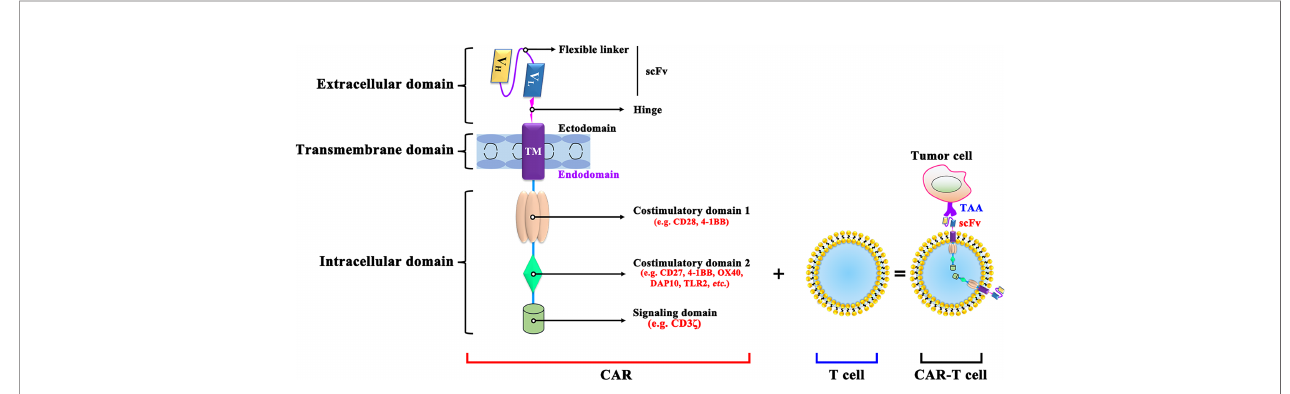
FIGURE 1 | The structure of CAR-T cell. V L , Light chain variable; V H , Heavy chain variable; ICOS, inducible costimulatory; ScFv, Single-chain variable fragment; DAP10, DNAX-activating protein 10; TLR2, Toll-like receptor-2; TAA, tumor-associated antigen; scFv: single-chain fragment